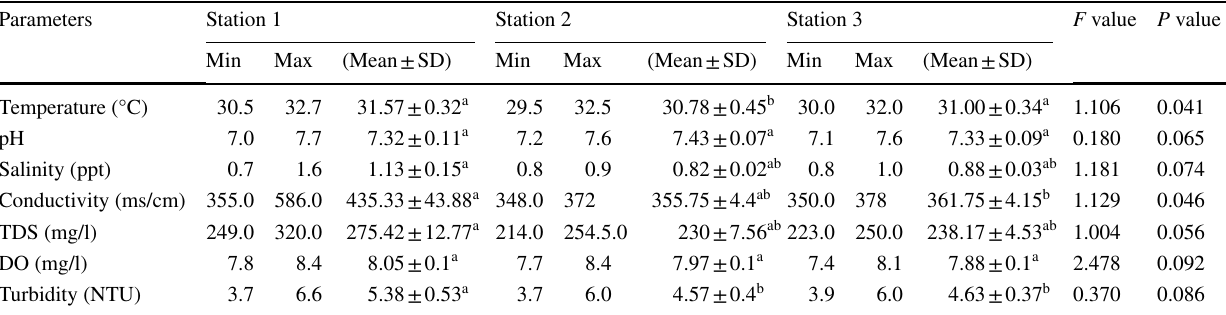
Table 1 Physicochemical characteristics of Tharavai wetland at selected sampling stations